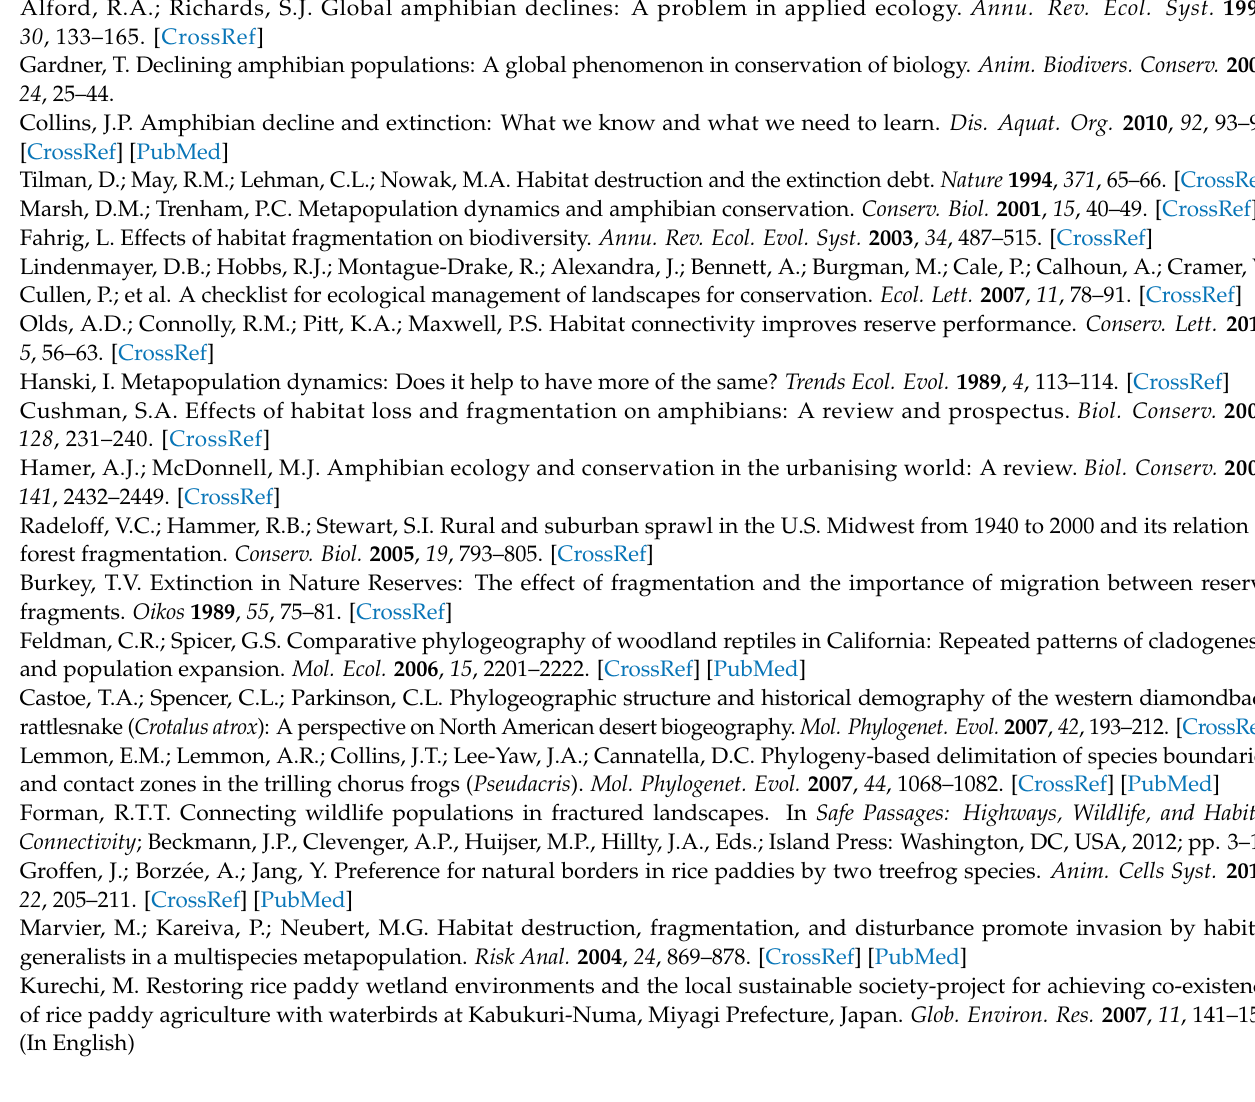
Figure A2. SDM results for Dryophytes suweonensis conducted with different regularization multiplier values. The model in (RM 2) used a regularization multiplier = 2 and the model in (RM 4) used a regularization multiplier = 4. We did not use these models in analyses as they clearly do no follow the ecological requirements of the species.